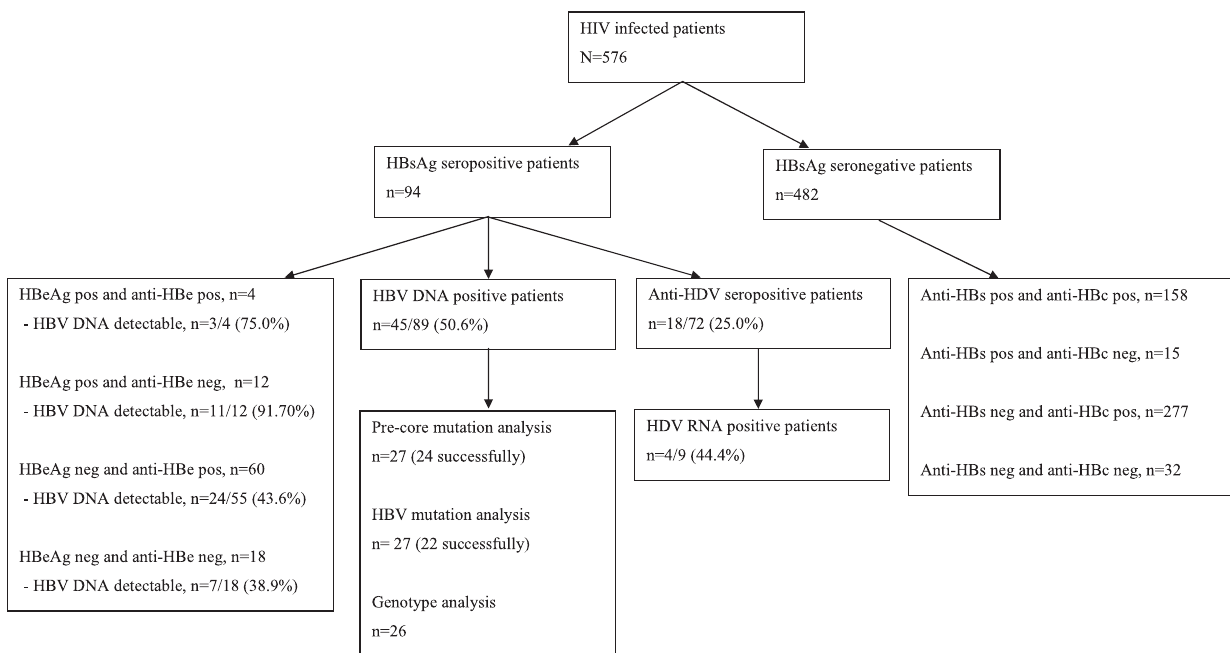
Figure 1. Serology and virological analyses among the HIV infected patients.